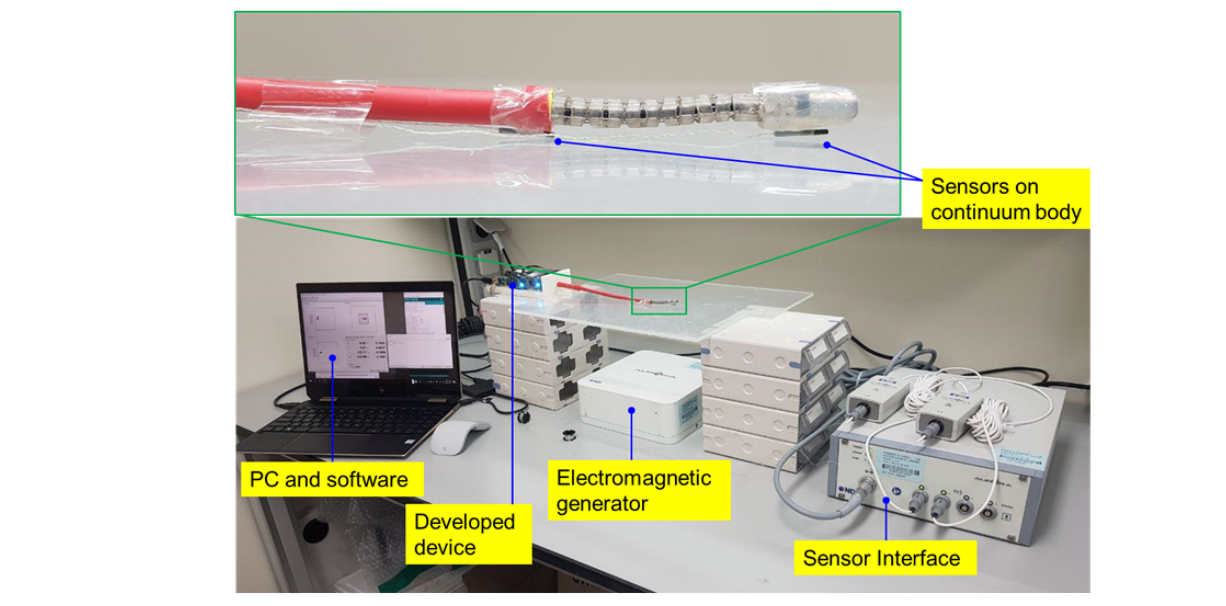
Figure 10. Sensor interface setup for the planar bending